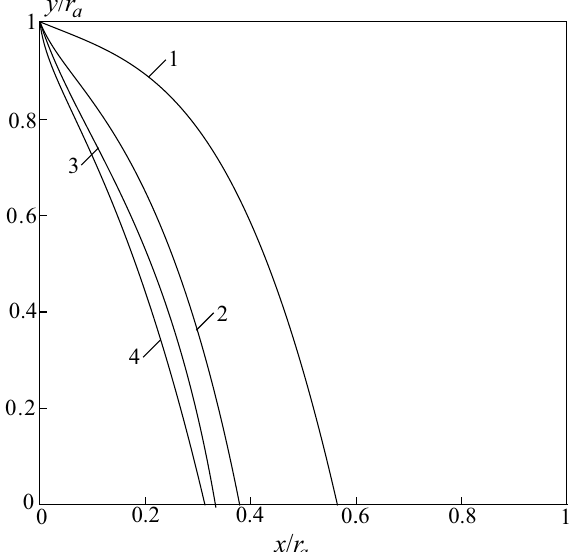
Figure 11. Sound line shape at various pressure drops at nozzle pressure ratios of 2 (line 1), 2.5 (Line 2), 3 (Line 3) and 4 (Line